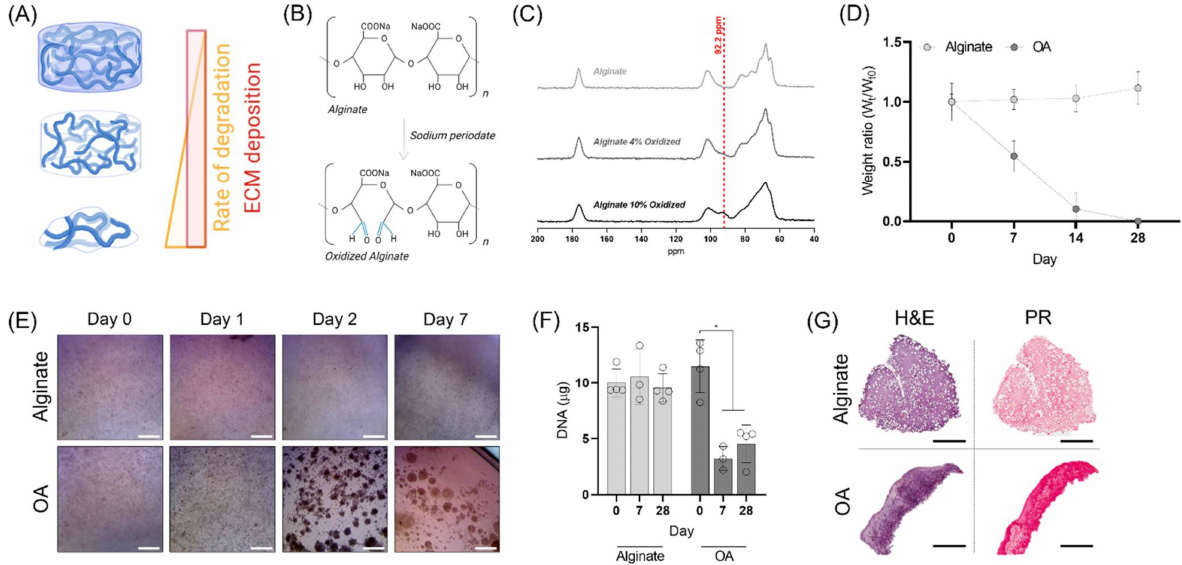
Figure 1. Oxidized alginate hydrogels. ( A ) ECM deposition in hydrogels presenting different degradation rates. ( B ) Reaction scheme of the alginate oxidation using sodium periodate. ( C ) 13C NMR spectra for alginates with different degradation rates. ( D ) Dry weight of oxidized alginate and raw alginate at various time points. ( E ) Macroscopic views of the cell-laden hydrogels at different time points. The scale bars are equal to 500 µ m. ( F ) DNA quantification in each construct at Day 0, Day 7, and Day 28. ( G ) Hematoxylin and eosin (H & E) and picrosirius red (PR) stainings after 28 days in culture. The scale bars are equal to 1 mm. * indicates significance p <